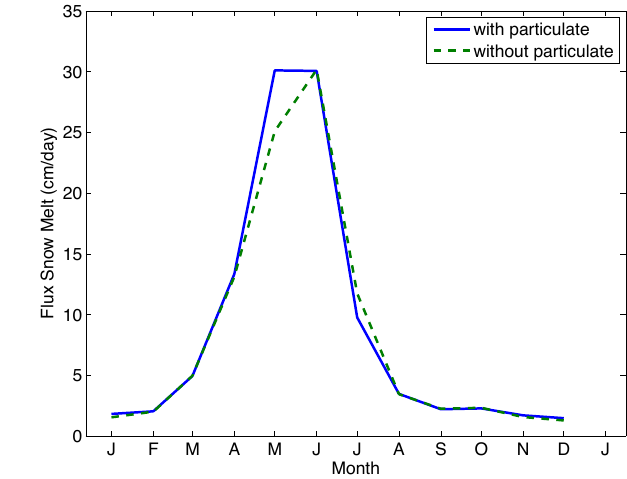
Fig. 6. The seasonal cycle of overall land surface albedo North of 60 ◦ N, both with and without the surface particulate impurity forc- ing applied. Note that the difference between the two varies with the time of year.